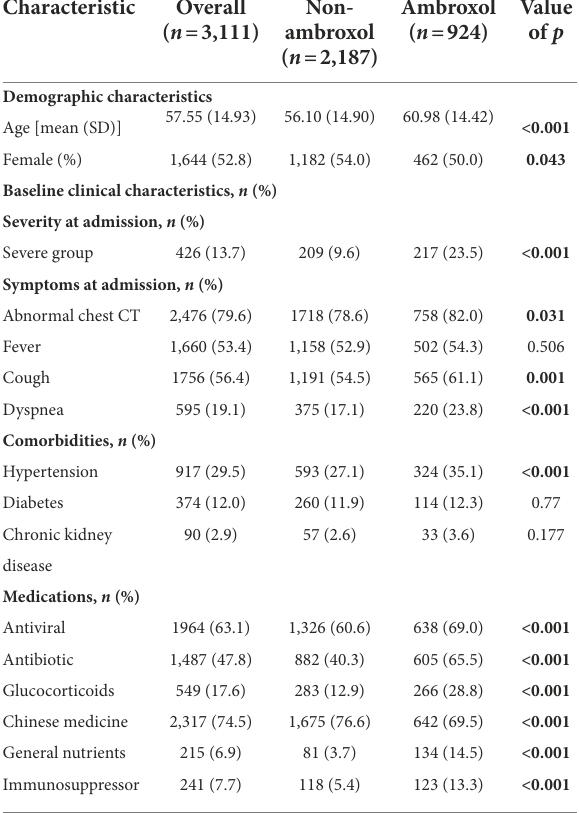
TABLE 2 Associations between inpatient ambroxol use and in-hospital